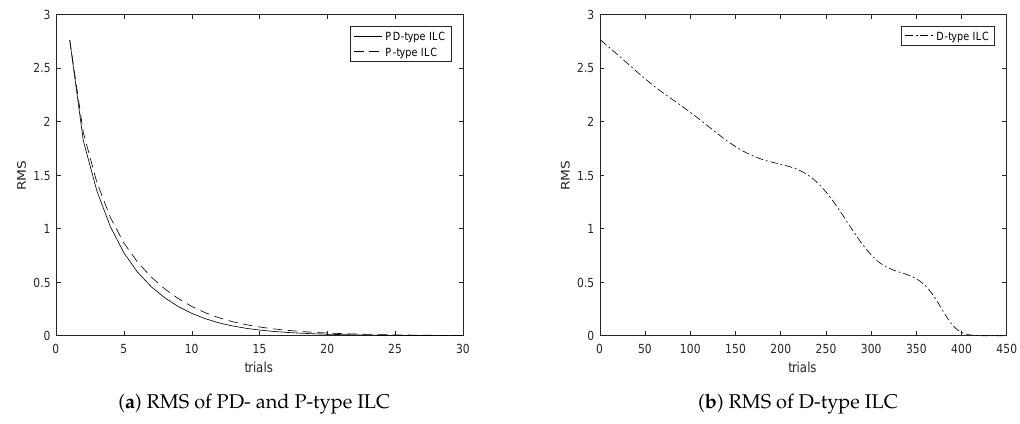
Figure 8. RMS of PD-, P- and D-type ILC for uncertain